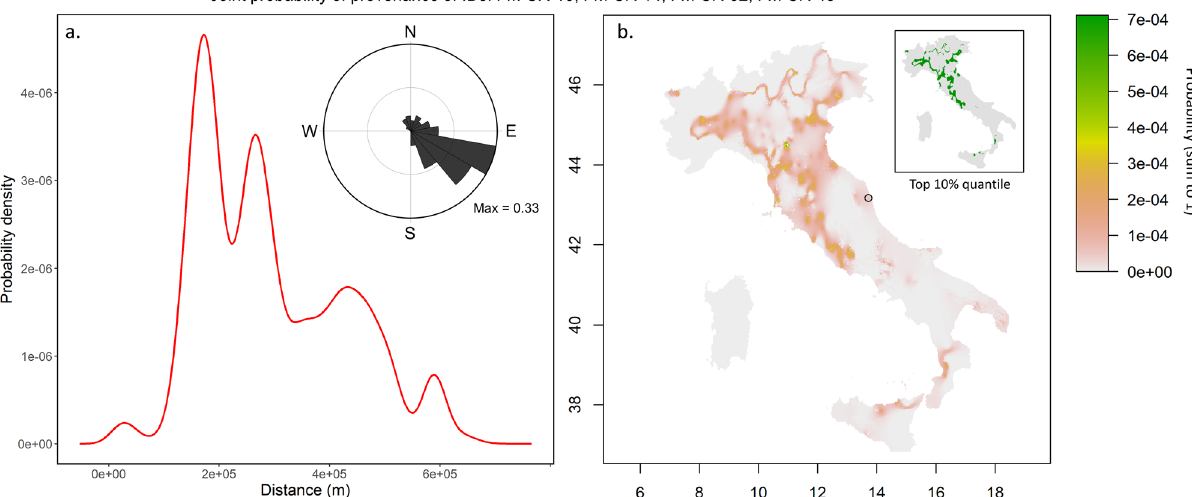
Figure 7. ( a ) Probability density plot representing the likely distance of movements for the most radiogenic non-local individuals (FM-SR-13, FM-SR-14, FM-SR-32, FM-SR-48; 87 Sr/ 86 Sr = (0.70952–0.70968)) from their hypothetical location of origin (see panel b) to reach Fermo. The distribution is multimodal with a peak at ~ 180 km, i.e. the most likely distance travelled by these individuals. In the inset, the bearings travel distribution shows the more likely path taken by the non-local individuals to reach Fermo. These values are obtained comparing the likely geographical origin of the sample (as depicted in panel b) and the site location. ( b ) Joint probability density surface showing the likelihood of geographical provenances for the non-local individuals. Each cell’s value represents the probability that the specific cell is the actual origin of the sample (green = highest probability, white = lowest probability, square cell side length = 2.5 km). The probabilities sum to 1. These analyses were performed in R, using the “assignR” package by Ma et al. 37 . The provenancing is based on the Universal Kriging model of the Italian Sr isoscape presented in Lugli et al. 24 . The map is built in R version 4.0.5 (see the code in the Supplementary Note; https:// www.r- proje ct.